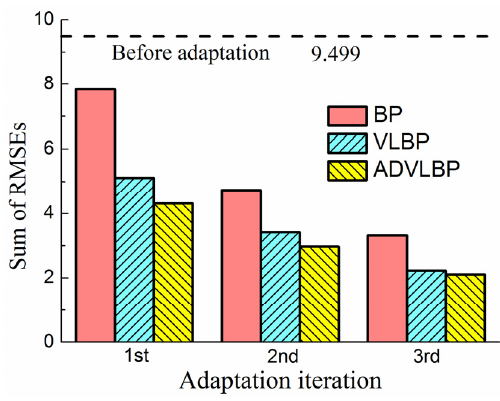
Figure 21. Comparison of training procedures.